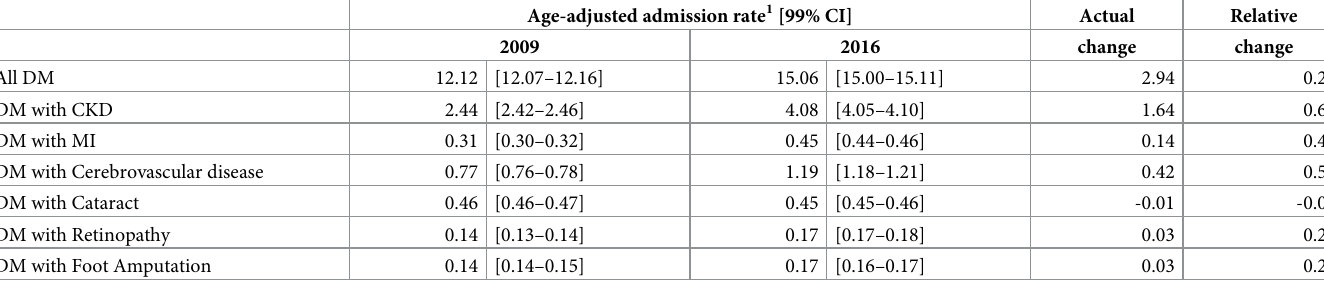
Table 3. Age-adjusted admission rate, actual change, and relative change between the year 2009 and